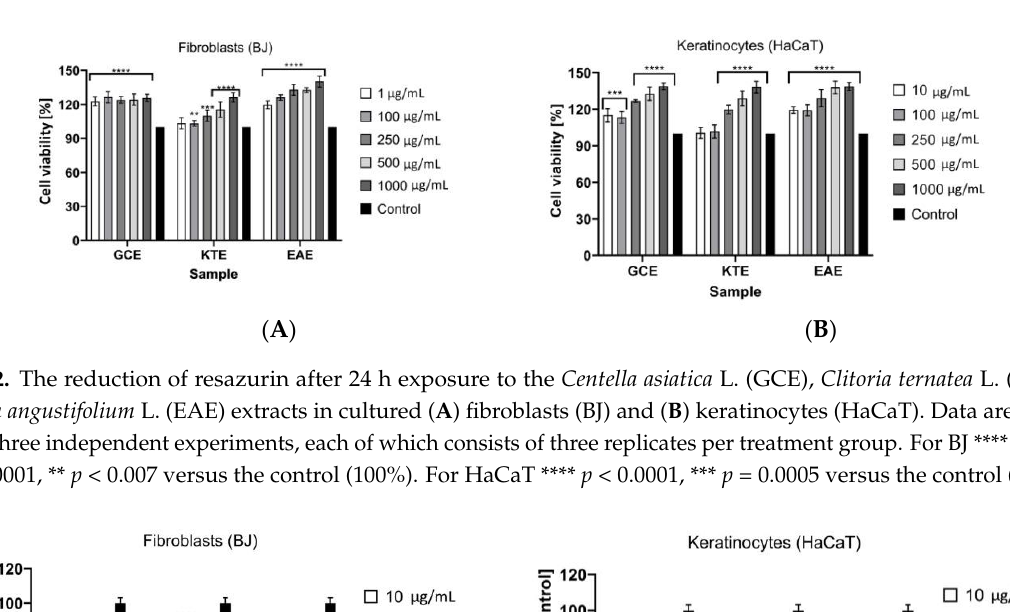
( B ) Figure 11. The effect of Centella asiaticaL . (GCE), Clitoria ternatea L. (KTE) and Epilobium angustifolium L. (EAE) (1–1000 μg/mL) on Neutral Red Dye uptake in cultured ( A ) fibroblasts (BJ) and ( B ) keratinocytes (HaCaT) after 24 h of exposure. Data are the mean ± SD of three independent experiments, each of which consists of four replicates per treatment group. For BJ **** p < 0.0001, *** p = 0.0002, * p < 0.0112 versus the control (100%). For HaCaT **** p < 0.0001, *** p = 0.0006, ** p < 0.0084 versus the control (100%). In the Alamar Blue test (Figure 12A,B) it was also indicated that analyzed extracts did not show any cytotoxic effects both for keratinocytes and fibroblasts. The strongest cell proliferation of fibroblast was noted for EAE extract. At the concentration of 1000 µg/mL the cell viability reached about 140%. In the concentration range of 100–500 μg/mL the value of the analyzed parameter was about 125–130%. For GCE extract it was not ob- served statistically significant differences and in each analyzed concentration cell viability reached about 125%. The lowest ability to increase fibroblast proliferation was observed for KTE extract. At the lowest tested concentrations of this extract, cell viability at the level of about 105–110% was observed, while at the concentration of 1000 µg/mL, an increase